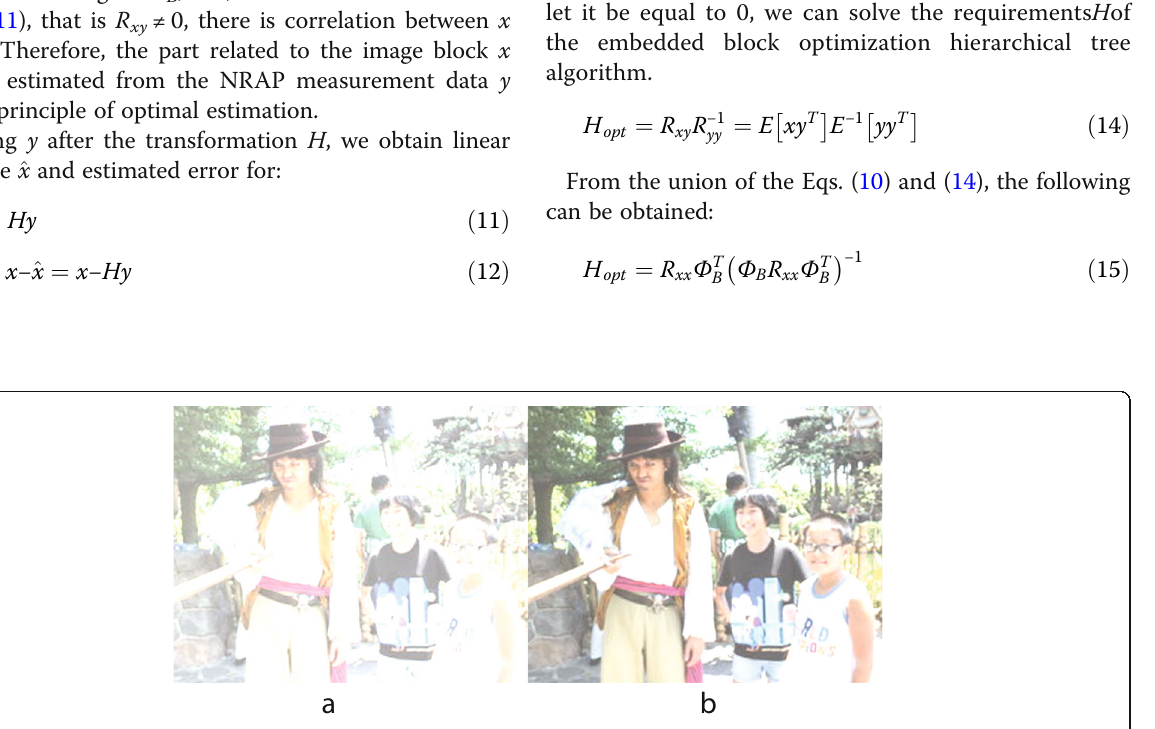
Fig. 7 Comparison between the algorithm and the traditional algorithm. a Traditional algorithm processing result diagram. b Algorithm processing result